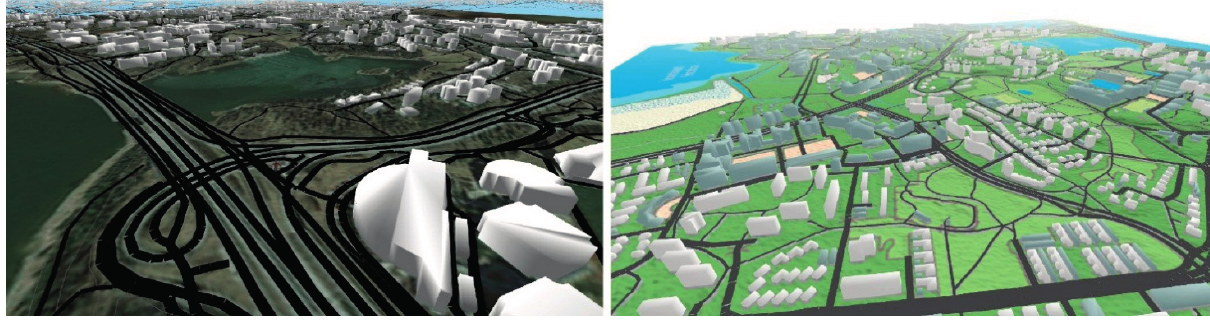
Figure 4. The terrain with the building and road models textured using an aerial image ( left ) and an edited map raster ( right